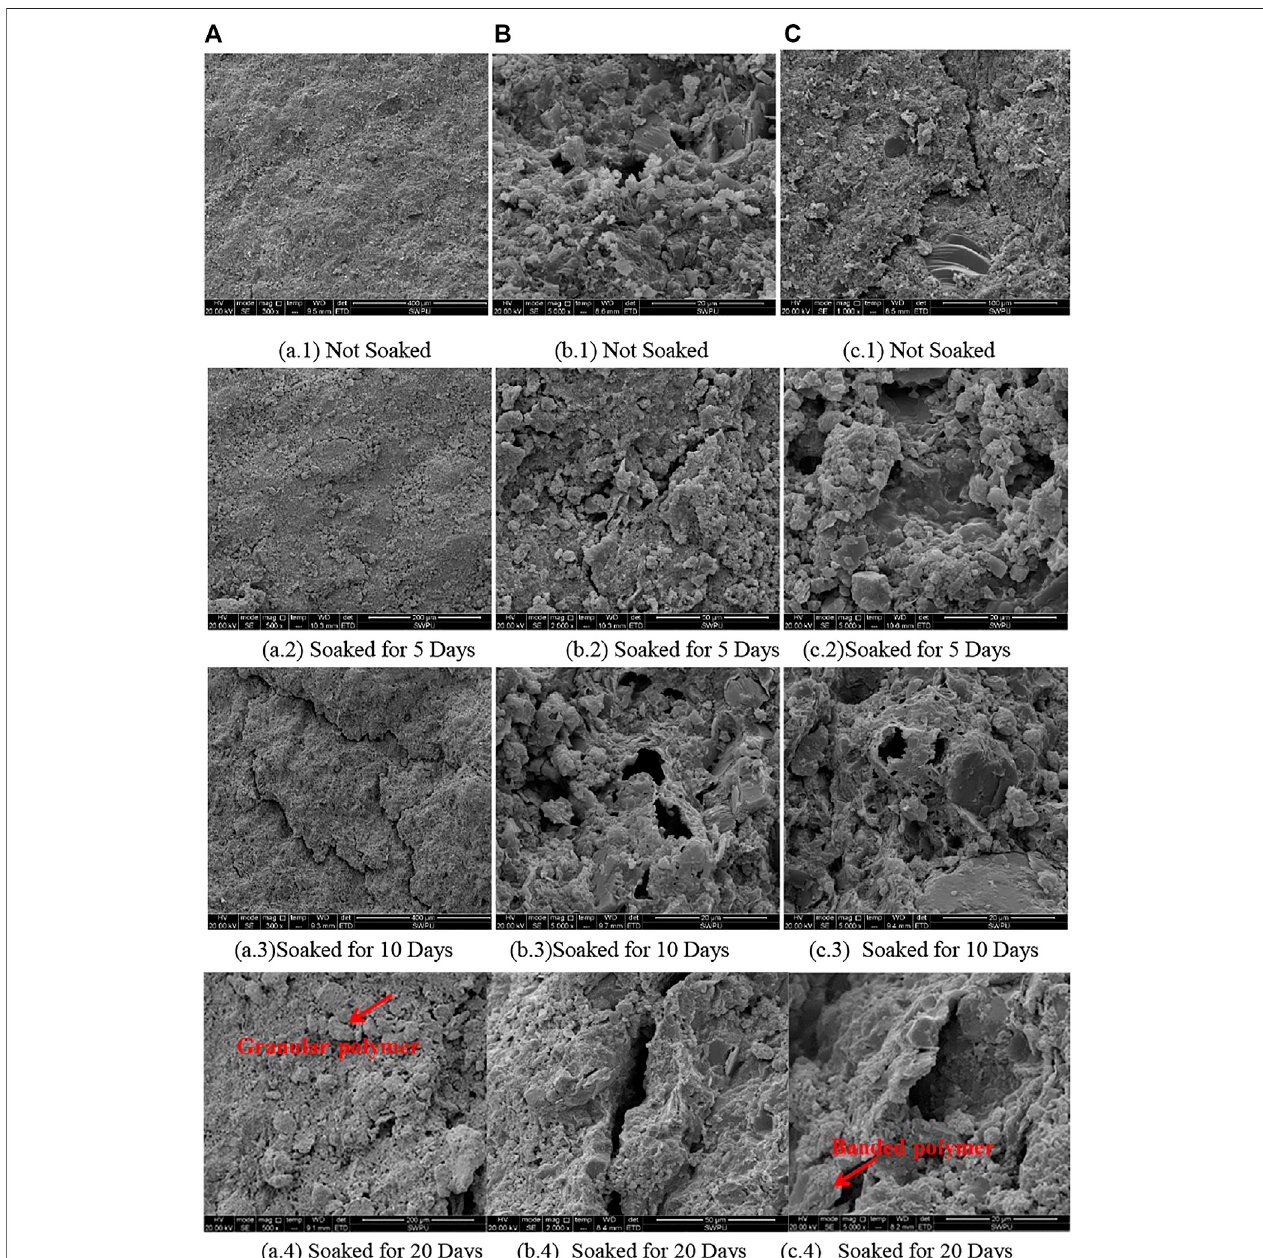
FIGURE4| TheoutcropoftheChangNingBlocksoakedintheslickwaterfracturing fl uidsystemfor0,1,5,10,15,and20days,respectively,forSEMexperiments; (A – C) show how the three outcrop change after soaked.